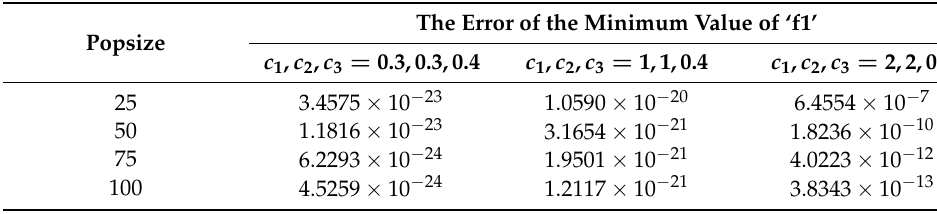
Table 1. The sensitivity analysis of c 1 , c 2 and popsize.